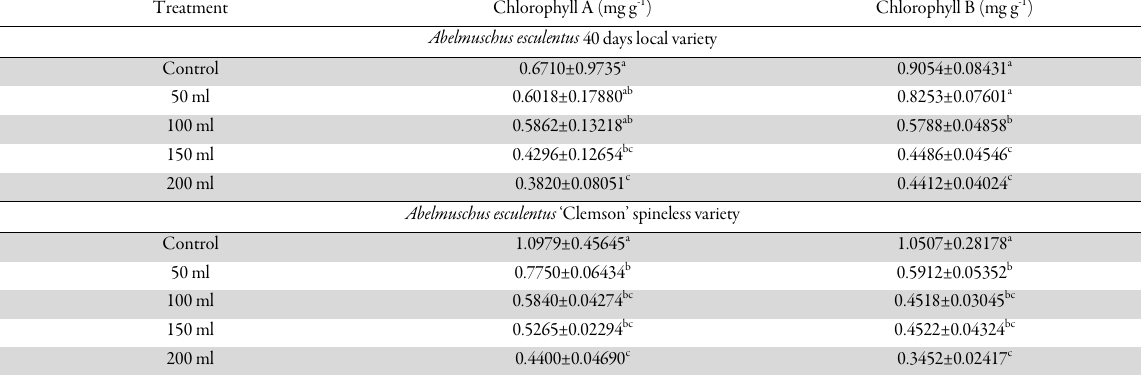
Table 6. Chlorophyll A and chlorophyll B content in plants as affected by different concentrations of spent engine